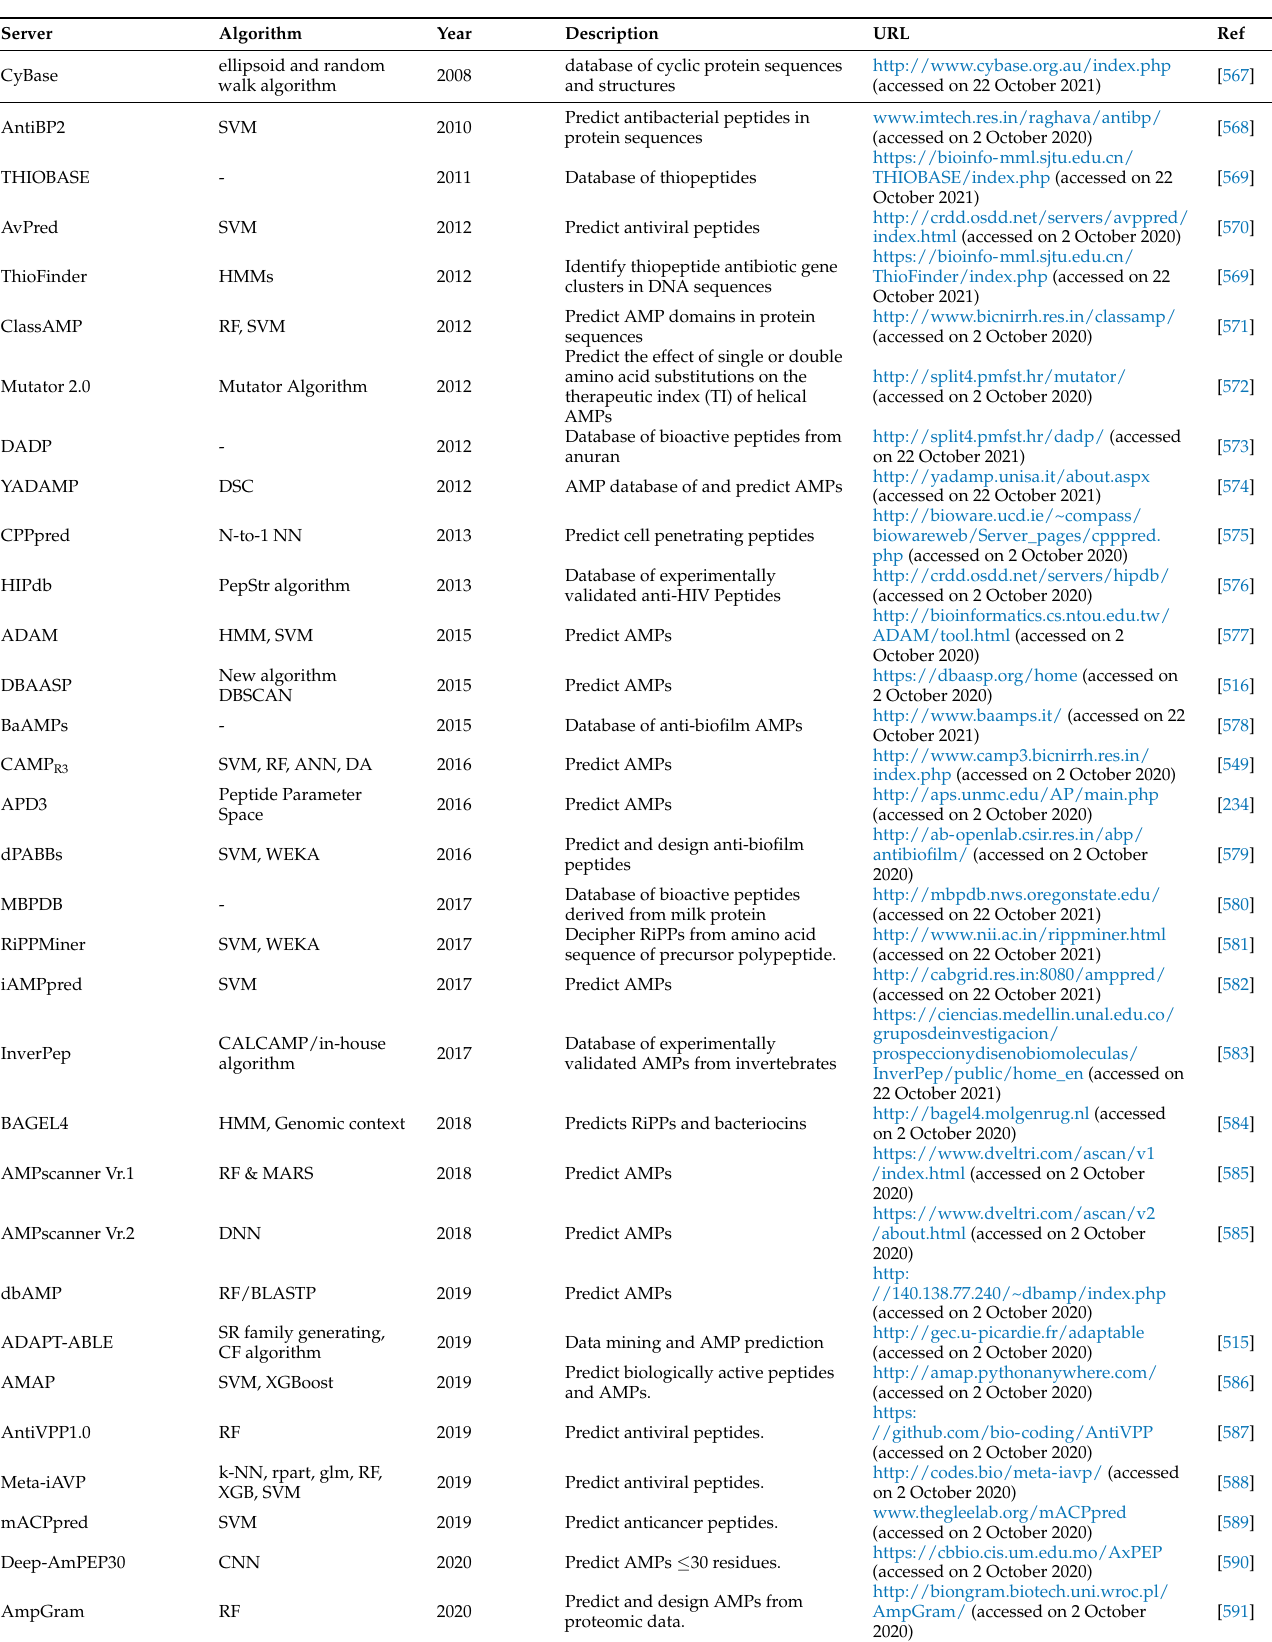
Table 3. Tabulated representation of AMP databases/servers for